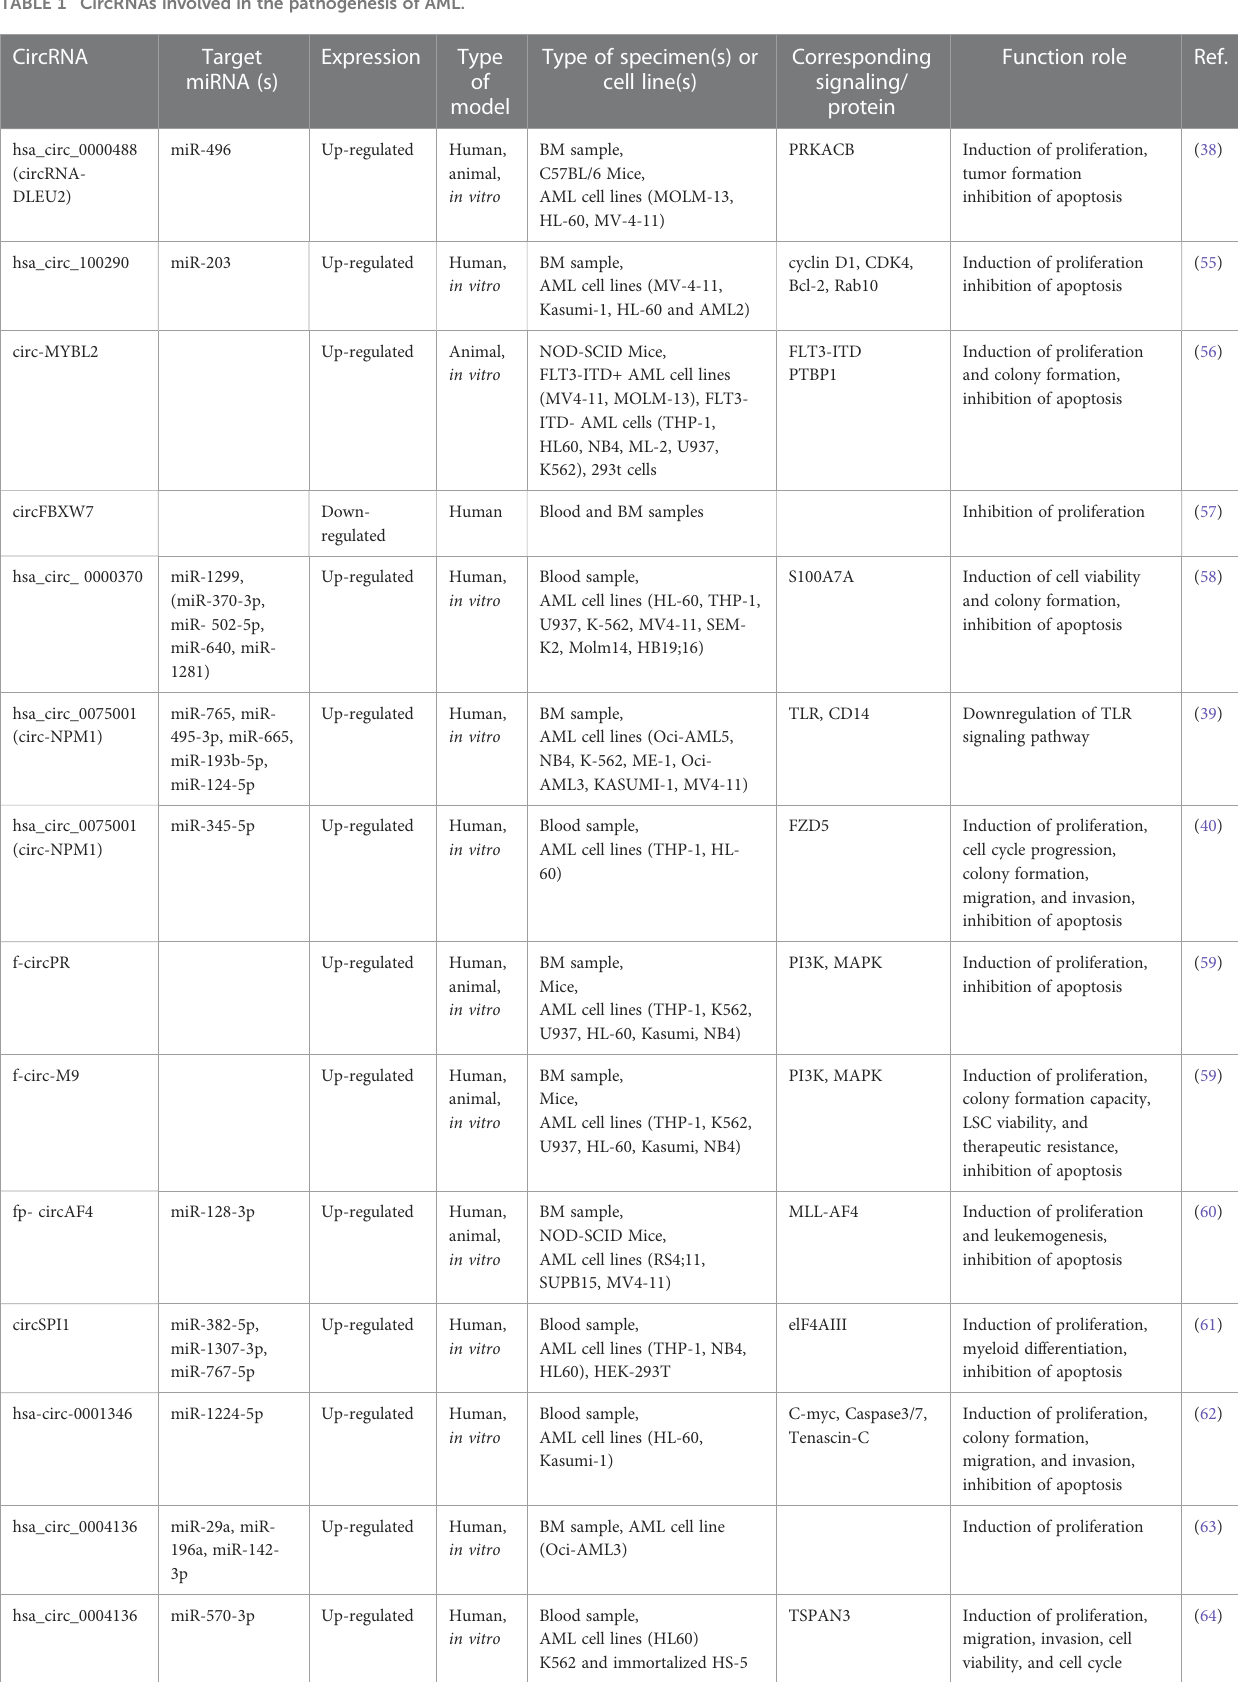
TABLE 1 CircRNAs involved in the pathogenesis of AML. CircRNA Target